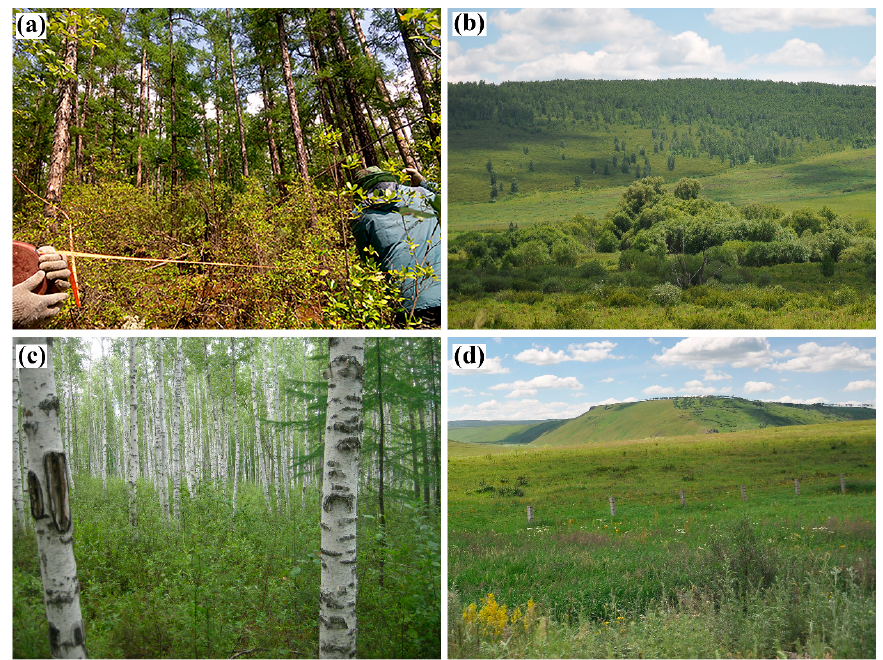
Figure 2. Images of typical ecosystems in four ecogeographical regions. ( a ) Larix gmelini–Rhododendron dauricum ecosystem in the MFN region; ( b ) Populus davidiana–Leymus chinensis ecosystem in the FGN region; ( c ) Betula platyphylla–Rhododendron dauricum ecosystem in the CMF region; ( d ) Stipa grandis–Leymus chinensis–Filifolium sibiricum ecosystem in the GLS region.